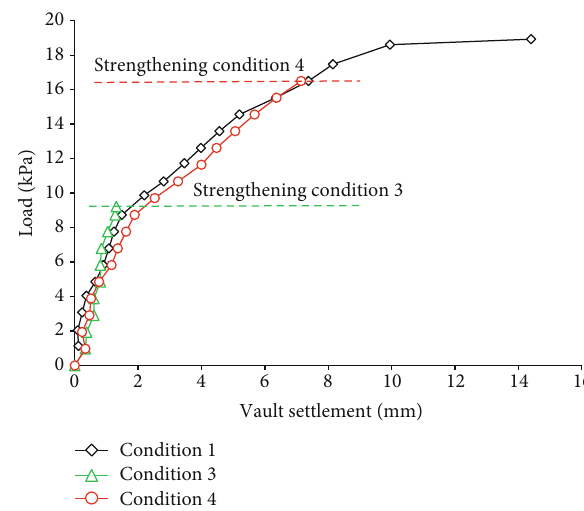
Figure 7: Curves of load-vault settlement with di ff erent conditions before